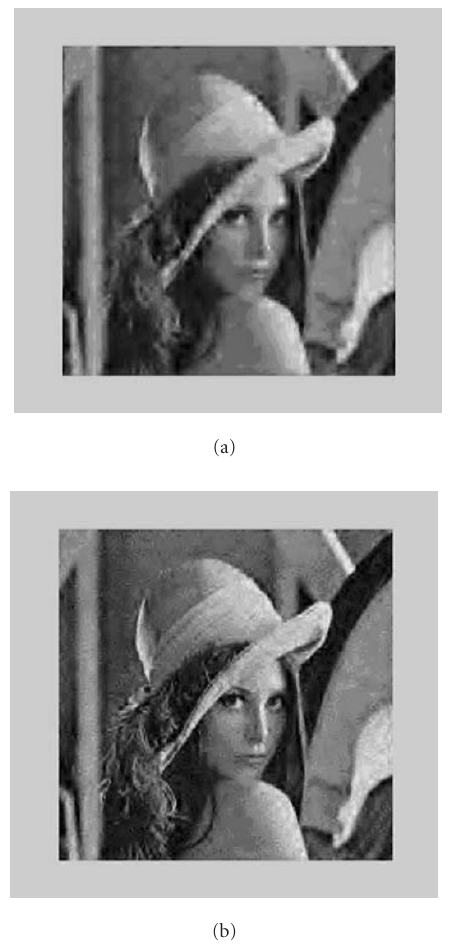
Figure 7: Denoised Lena image by repeated row prefiltering: (a) decomposed with the GHM multiwavelet and thresholded with the univariate scheme; (b) decomposed with the CL multiwavelet and thresholded with the proposed scheme.